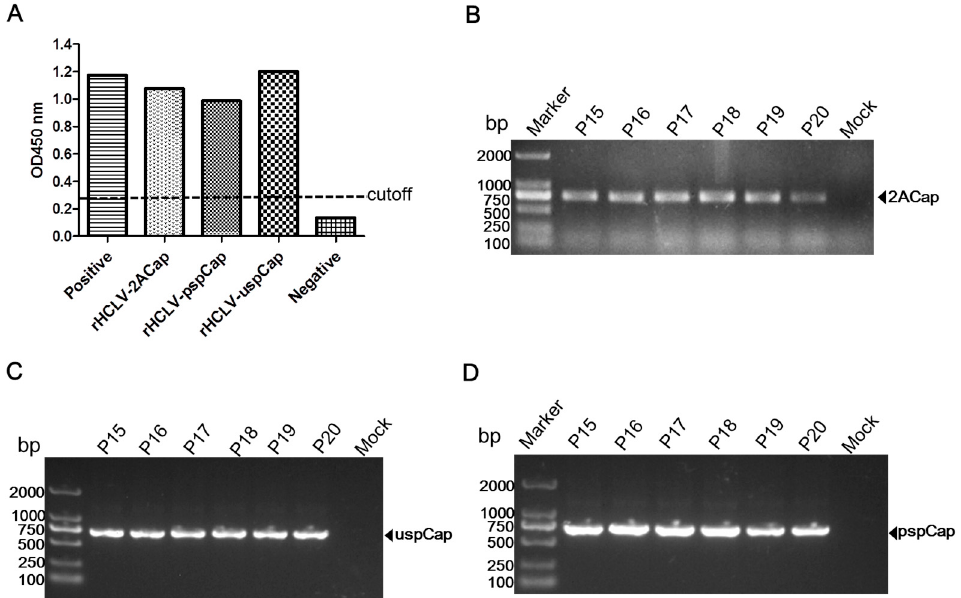
Figure 2. Identification of the generated recombinant viruses. ( A ) The E rns protein of three recombinant viruses was tested by antigen-capture ELISA. The supernatants from the cells inoculated with the recombinant viruses were tested by an antigen-capture ELISA (IDEXX); ( B – D ) the inserted genes remained stable in the recombinant viruses. The Cap gene was amplified from viral RNA of passage 15 (P15) to P20 rHCLV-2ACap ( B ), rHCLV-uspCap ( C ), and rHCLV-pspCap ( D ) by RT-PCR.